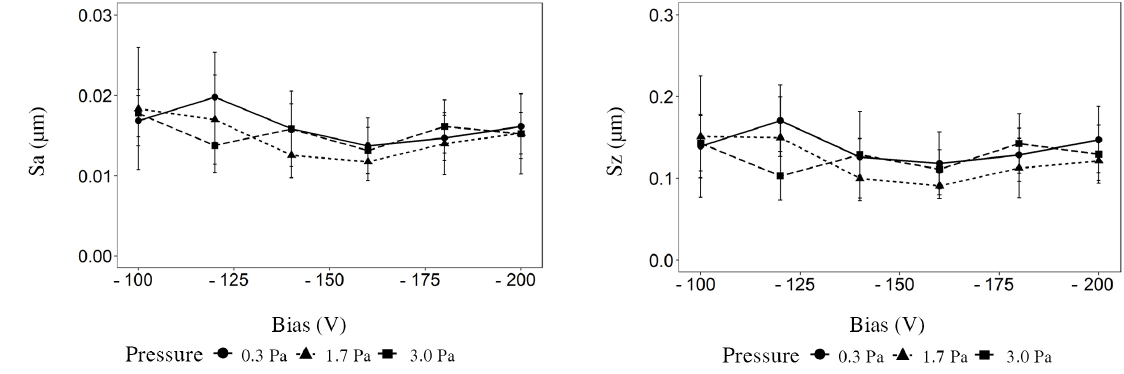
Figure 6. Scatter plot and response surface of surface roughness Sa and Sz (as coated). The mean peak height S pk also exhibits a local minimum of 0.009 µm–0.016 µm at a bias of − 160 V for all pressures in this test series (Figure 7). S vk shows a minimum at − 180 V. The quadratic proportion of the substrate bias presents a significant processing factor for S pk and S vk in the table of Figure 7.